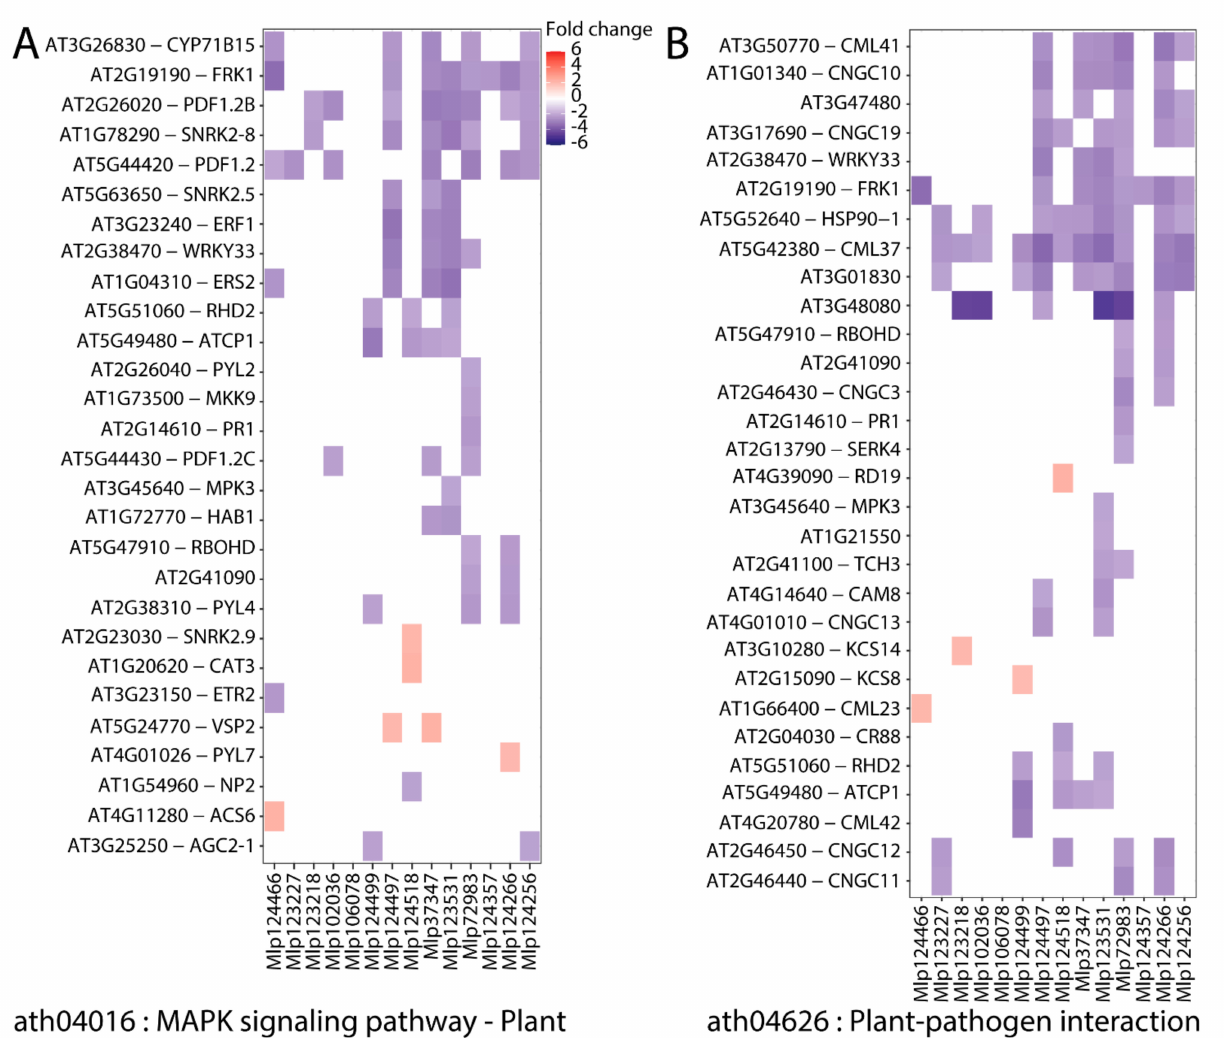
Figure 5. Heatmaps of genes belonging to ( A ) MAPK signaling pathway and ( B ) Plant–pathogen interaction deregulated in this experiment. Up- and down-regulated genes are shown in red and blue, respectively. Transgenic lines are ordered according to dendrogram of sequence similarity calculated with Muscle and UPGMA. The underlying data for this figure can be found at dos Santos et al.